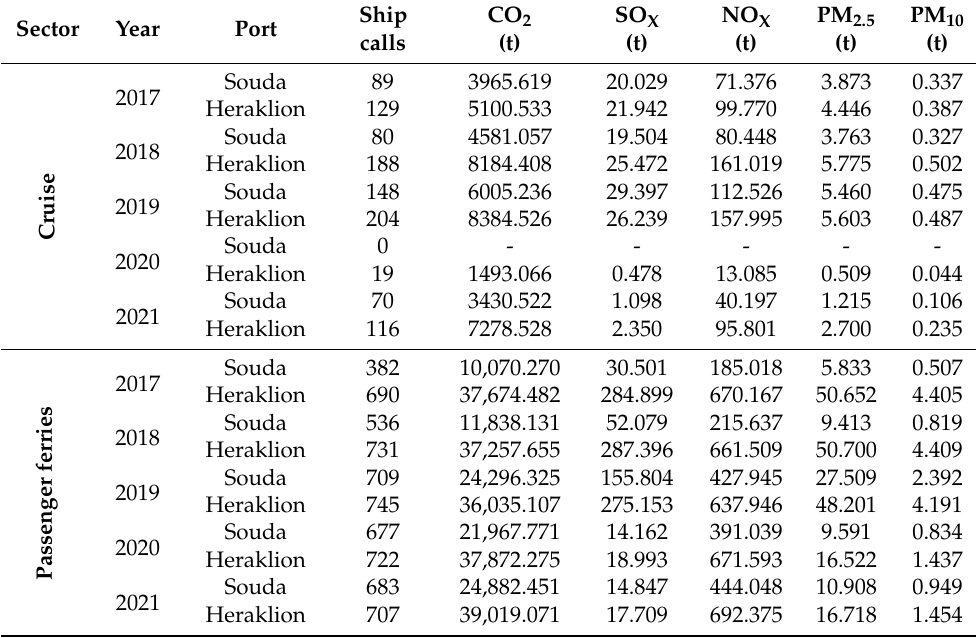
Table 3. Air emissions for ports Souda and Heraklion (years